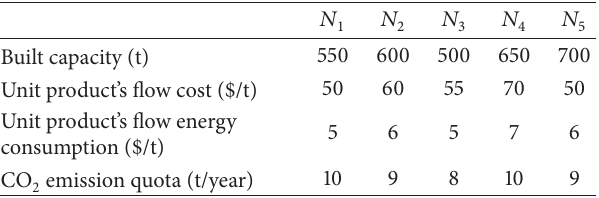
Table 5: Parameters of distribution centers.